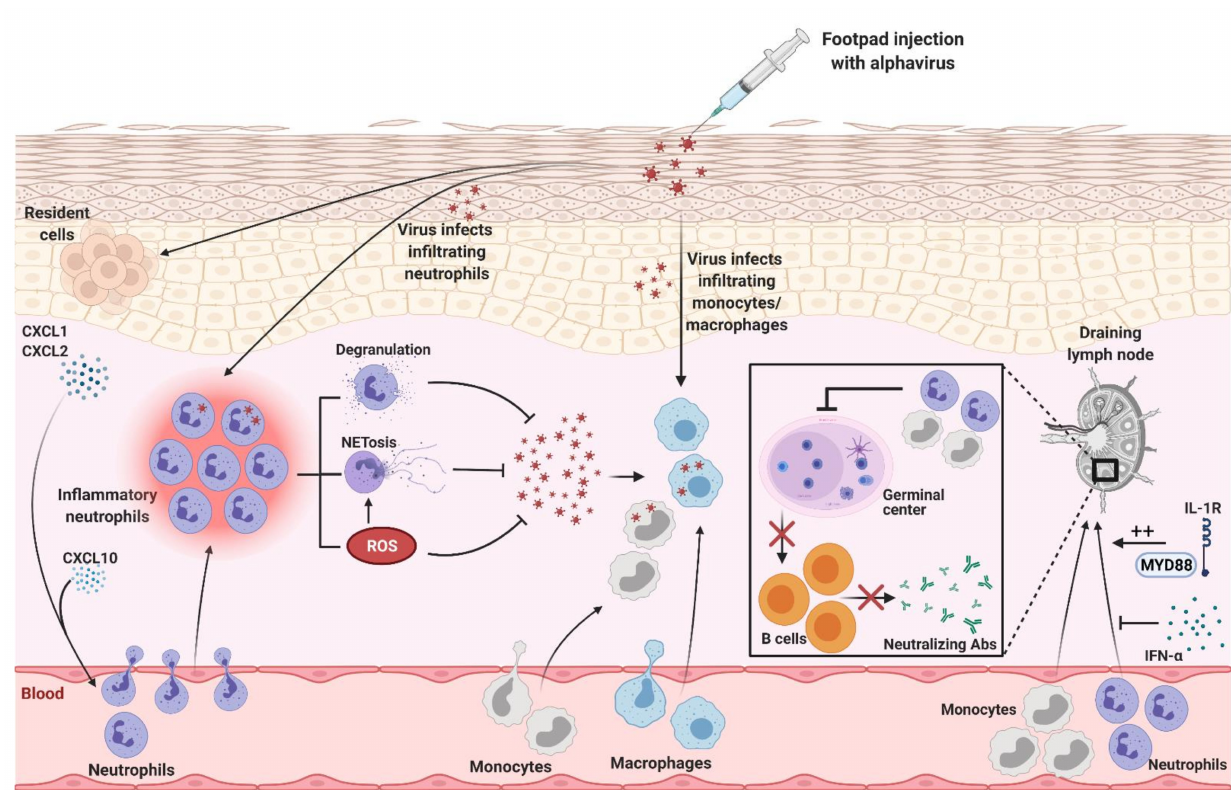
Figure 2. Alphavirus infection-induced neutrophil recruitment and inflammation. Following footpad injection of mice with alphavirus, levels of neutrophil-attracting chemokines, CXCL1 and CXCL2, increase. These chemokines and CXCL10 recruit neutrophils, which release reactive oxygen species (ROS), neutrophil extracellular traps (NETs), and other cytotoxic mediators through degranulation, promoting viral clearance. The infiltrating neutrophils can also be directly infected, triggering NET release in a ROS-dependent manner. Furthermore, monocytes/macrophages infiltrating the site of infection can be directly infected. On the other hand, alphaviral infections induce monocyte and neutrophil recruitment into the draining lymph node (dLN) that inhibit germinal center formation decreasing B cell maturation and neutralizing antibody (Ab) production. MyD88-IL-1R signaling promotes the accumulation of neutrophils in the dLN, while IFN- α inhibits this